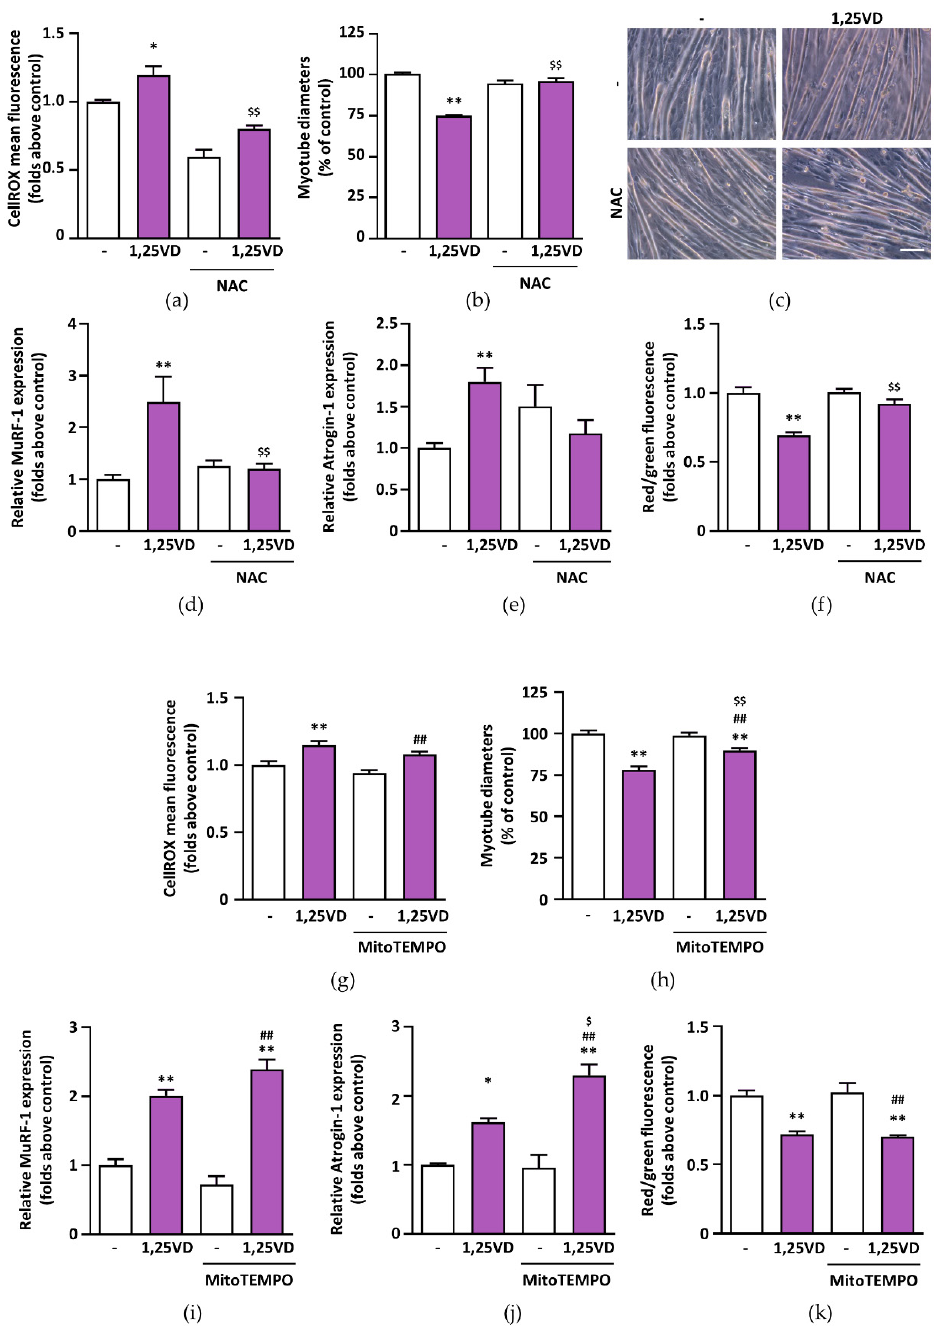
Figure 7. NAC, but not mitoTEMPO, inhibits 1,25VD-induced atrophy in C2C12 myotubes. C2C12 myotubes were treated in serum-free medium with 100 nM 1,25VD in the presence or absence of 5 mM NAC for 24 h. At the end of the treatments, ( a ) cells were stained with CellROX Deep Red reagent to quantify ROS levels and ( b ) myotube diameters were mea- sured with JMicroVision software. ( c ) Phase-contrast representative images of treated myotubes. Scale bar 200 µ m. The expression of ( d ) MuRF-1 and ( e ) Atrogin-1, normalized on Gusb , was assessed by Real-Time PCR. ( f ) Mitochondrial membrane depolarization was analyzed by JC-1 assay. To assess whether the mitochondrial ROS production was involved in the 1,25VD-induced atrophy, differentiated C2C12 myotubes were treated for 24 h in serum-free medium with 100 nM 1,25VD with or without 10 µ M mitoTEMPO and ( g ) ROS levels, ( h ) myotube diameters, ( i , j ) atrogene expression, and ( k ) mitochondrial depolarization were analyzed as described above. Data are presented as means ± SEM of three indepen- dent experiments. * p < 0.05, ** p < 0.01 compared to vehicle-treated cells; $ p < 0.05; $$ p < 0.01 compared to 1,25VD-treated cells; ## p < 0.01 compared to mitoTEMPO-treated